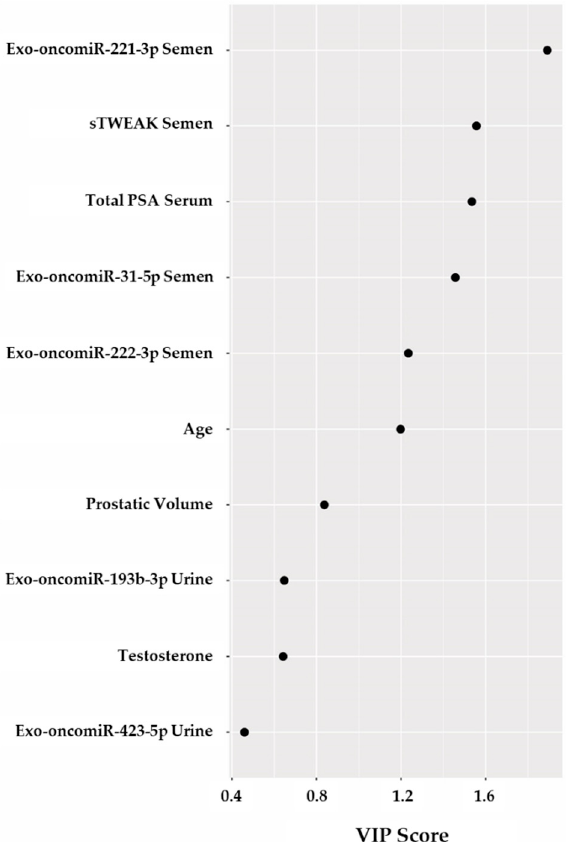
Figure 3. Variable importance in projection (VIP) scores. Selected variables: total PSA, testosterone, prostatic volume, age, sTWEAK in semen, exo-oncomiR-221-3p, exo-oncomiR222-3p, exo-oncomiR31-5p, exo-oncomiR-193-3p and exo-oncomiR-423-5p are shown in the model. Variables with scores close to or greater than 1 were considered important in the model. Table 3. Exo-oncomiRNAs-based models as diagnostic classifiers.